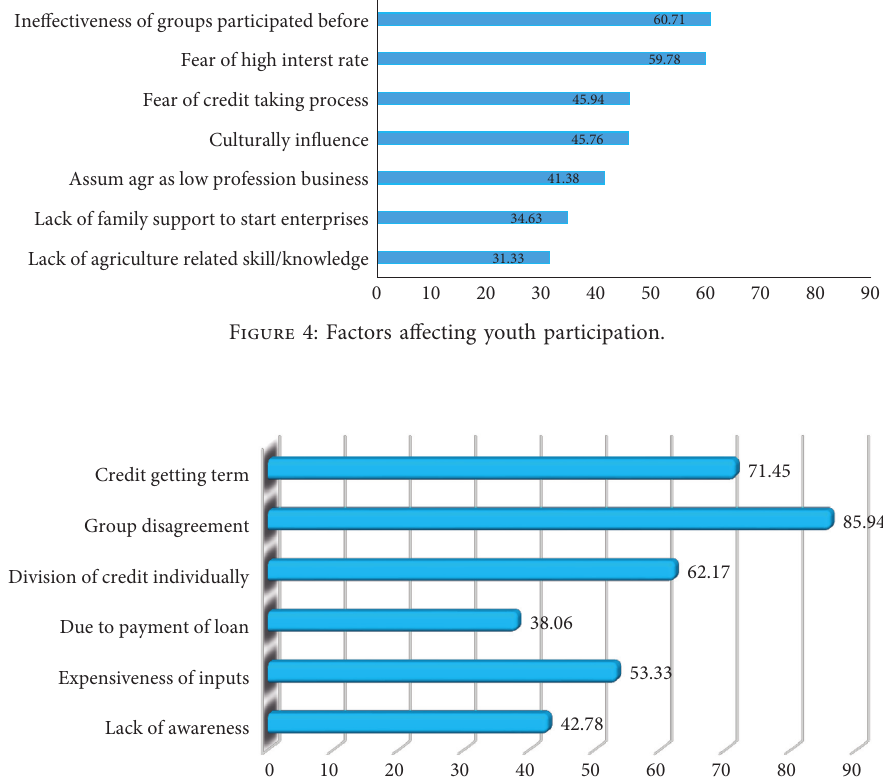
Figure 5: Reasons for not running the grouped